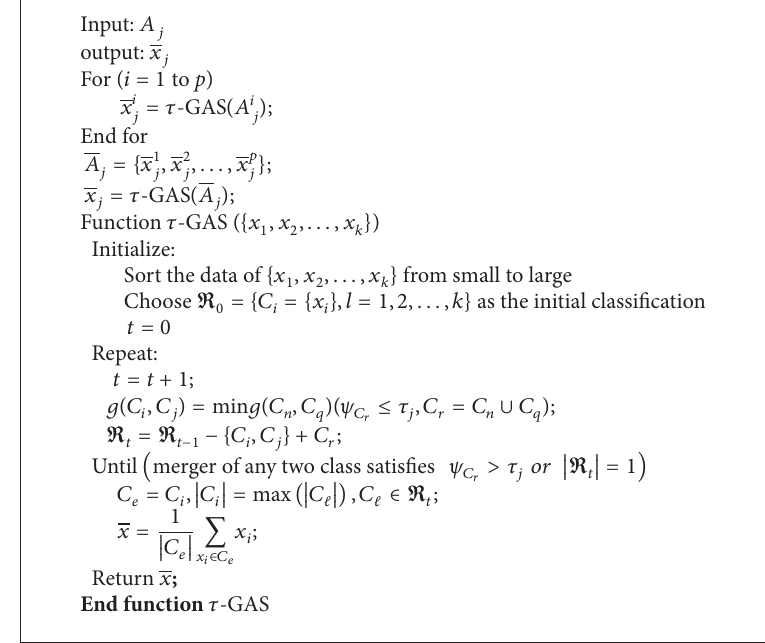
Algorithm 2: Two-dimensional 𝜏 -GAS algorithm.